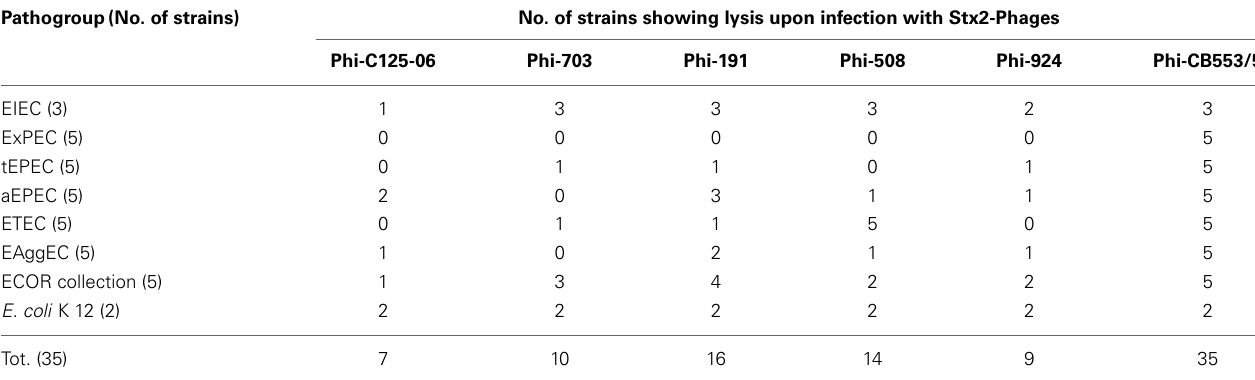
Table 1 | Results of the spot agar assays showing the susceptibility of the E. coli strains to infection with the different stx2 -phages used. Pathogroup(No. of strains) No. of strains showing lysis upon infection with